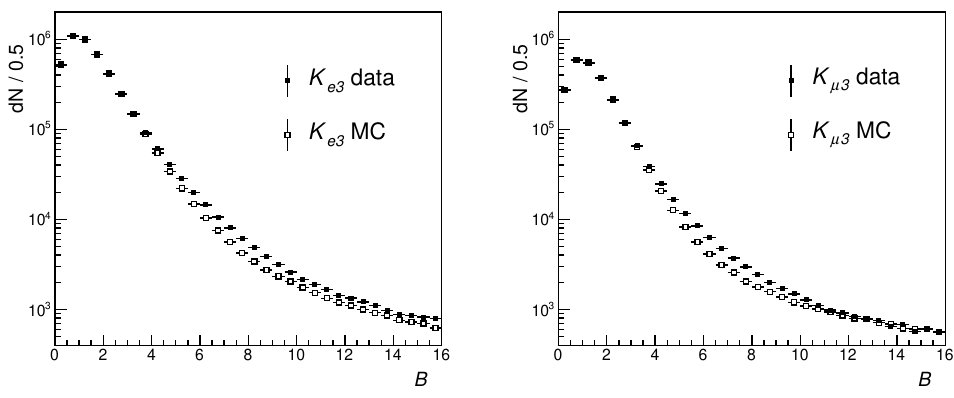
(left) and K (cid:6) (right) for data and e 3 (cid:22) 3